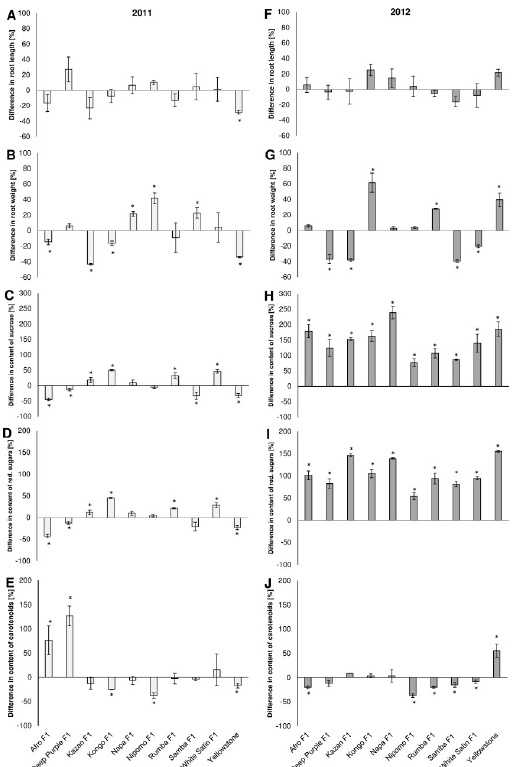
Fig 5. Effects of hawthorn-carrot aphid (Dysaphis crataegi ) foraging on the length (A, F), weight (B, G), and contents of sucrose (C, H), reducing sugars (D, I) and carotenoids (E, J) in the roots of the ten tested carrot cultivars. � Significant differences between the control mean and the mean in colonized plants based on the Student’s t test conducted separately for each cultivar (P < 0.05).